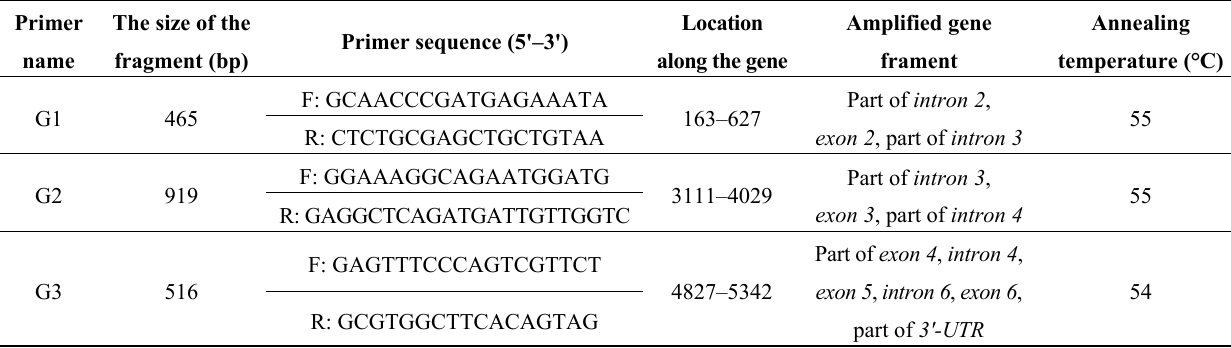
Table 3. Primer sets used for the identification of single nucleotide polymorphisms (SNPs) in the growth hormone ( GH ) gene in S. chuatsi